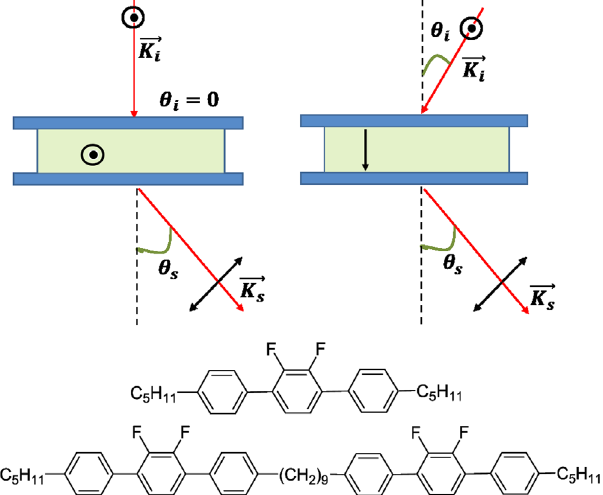
FIG. 2. Top diagram: Light-scattering geometries G1 (left) and G2 (right) described in the text, with the average director (optic axis) in the sample cell indicated by the arrow pointing out of the page for G1 (homogeneous planar alignment with average ˆ n normal to the scattering plane) or the downward arrow for G2 (homeotropic alignment with average ˆ n in the plane). The orientations of polarizer and analyzer are similarly indicated. Bottom diagram: Chemical structure of the monomer and dimer compounds utilized for the present study. The 30 = 70 wt % mixture exhibits a N-N phase transition at 94 . 2 TB